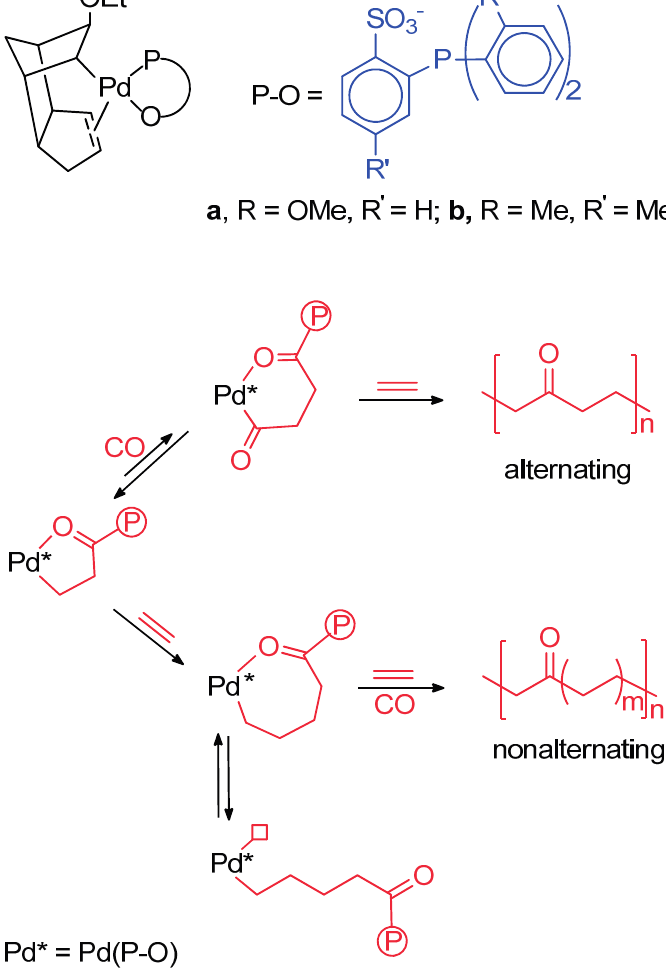
Figure 11. Catalysts for the CO-ethene copolymerization and alternating and nonalternating